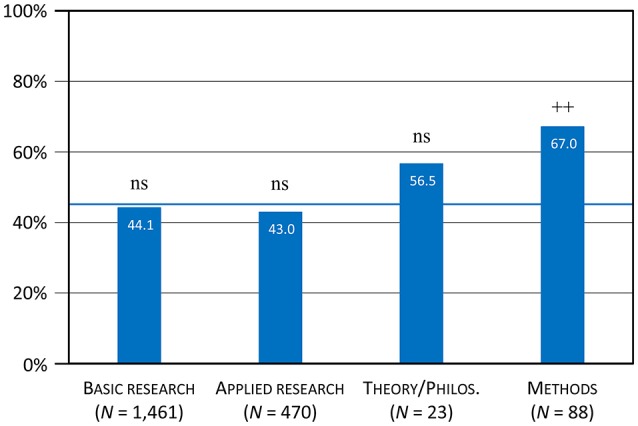
Proportion of specialty categories with theory-related terms (Table 5B, all six terms). The blue line represents the average proportion of 45.0% based on the total of 2,042 articles.